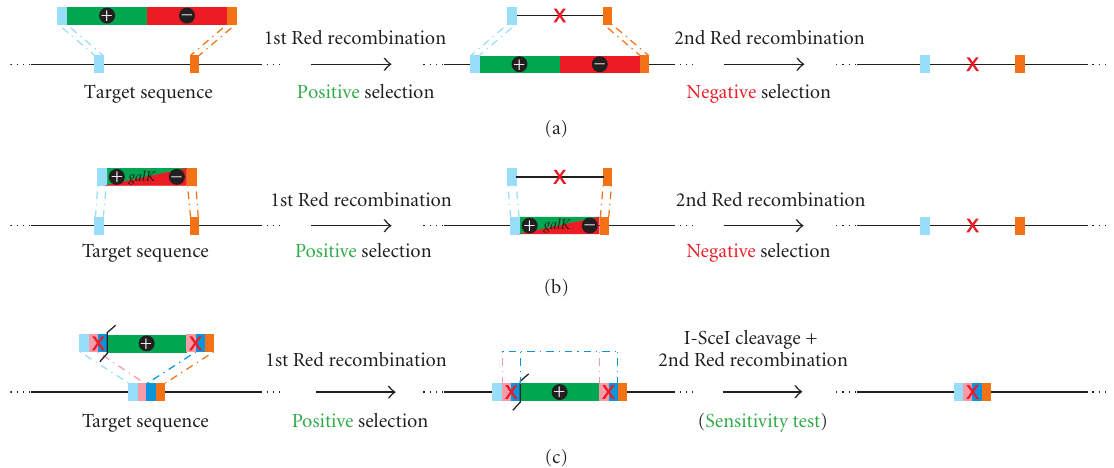
Figure 4: Overview of strategies that allow sequence editing of the target sequences. Boxes of same color represent identical